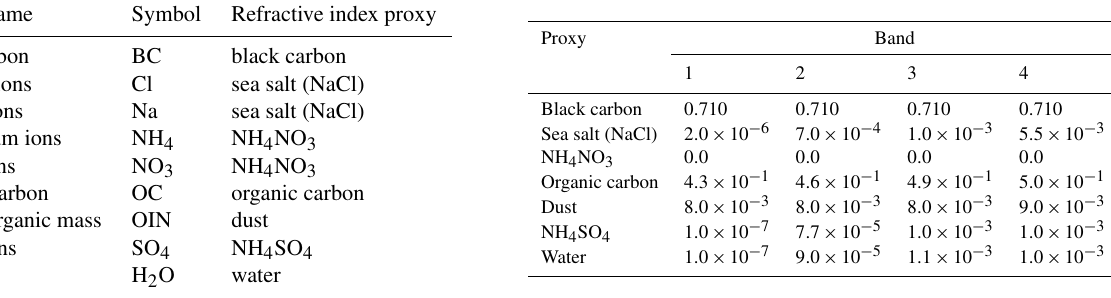
Table A3. Imaginary parts of the refractive indices of the proxies listed in Table A1 at the centres of the geoCARB spectral bands.